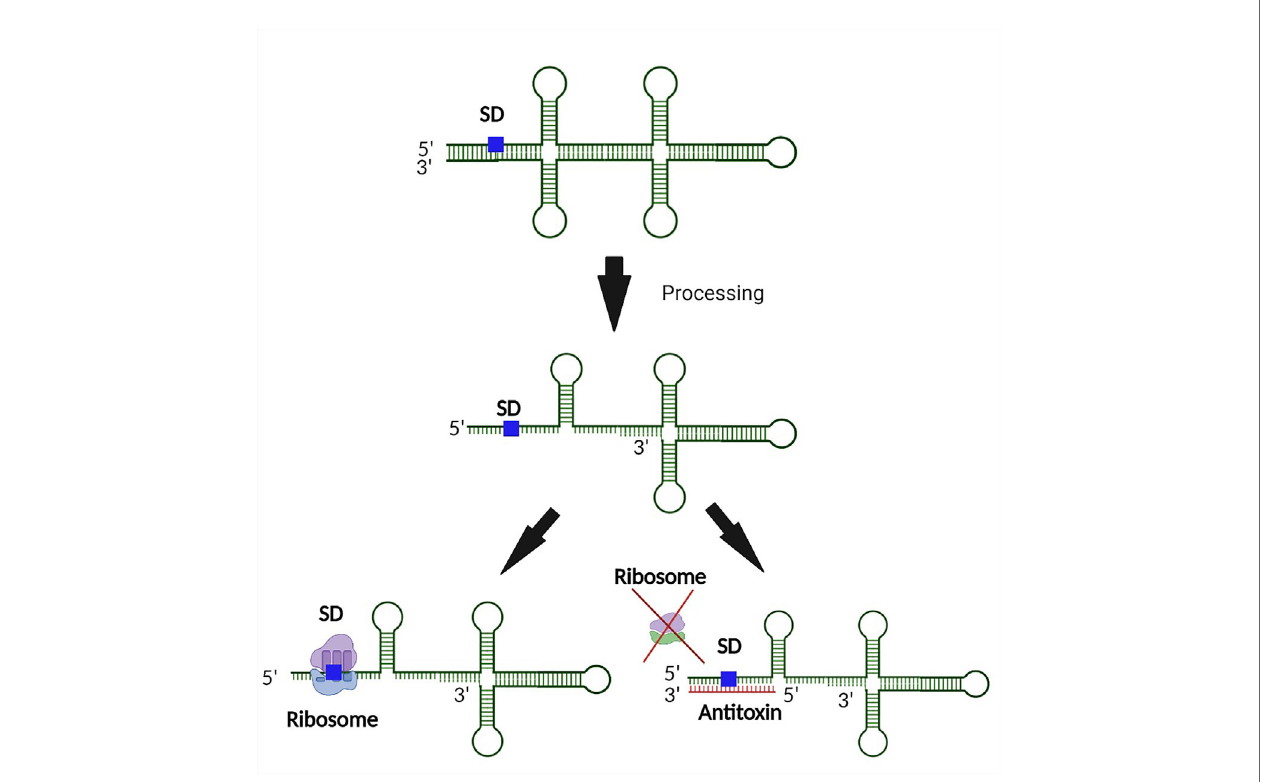
FIGURE 5 | 3 ’ end processing represents a second layer of regulation controlling the production of some Type I toxins. In the event an inhibitory secondary structure formed by binding between the 5 ’ and 3 ’ end of the toxin transcript, 5 ’ end processing is required to expose both the SD and antitoxin binding site. Upon exposure of the binding region, translation of the toxin is further regulated by an interaction between the antitoxin and the SD of the toxin transcript such that ribosomal binding is inhibited. Such dual regulation ensures minimal production of the Type I toxin when its activity would be deleterious to the bacterium.